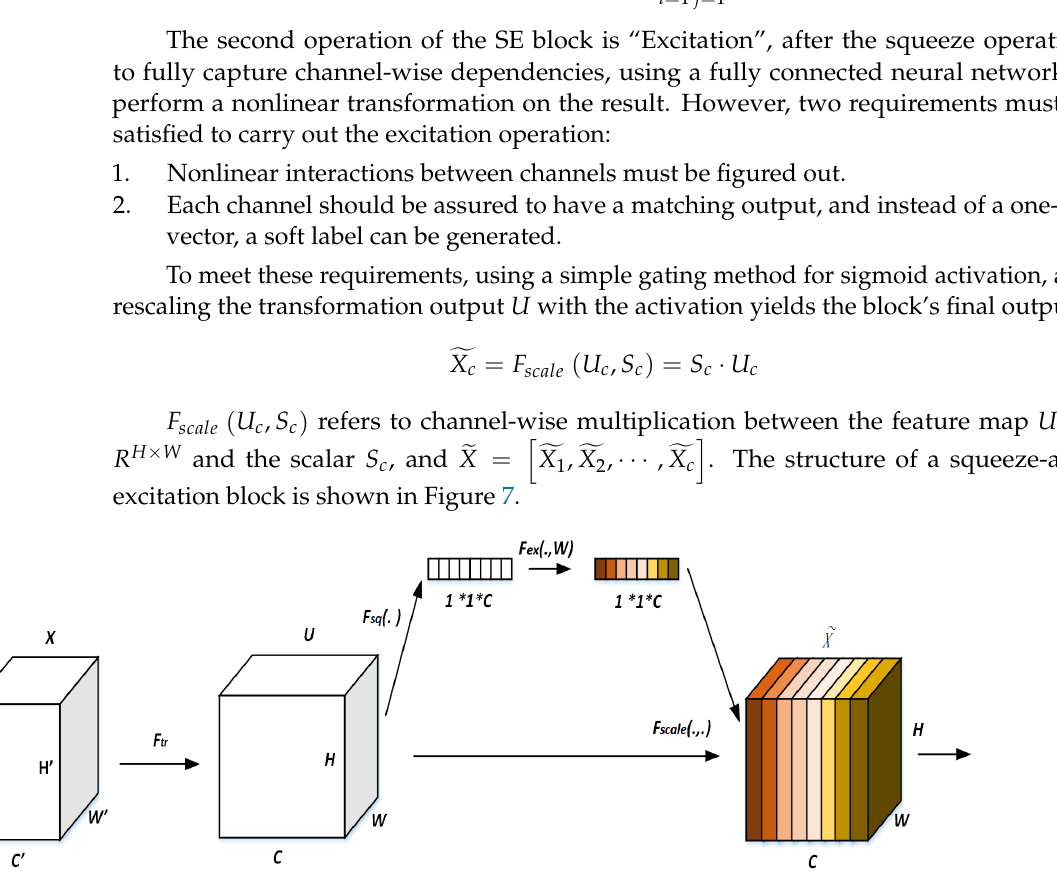
Figure 7. A squeeze-and-excitation